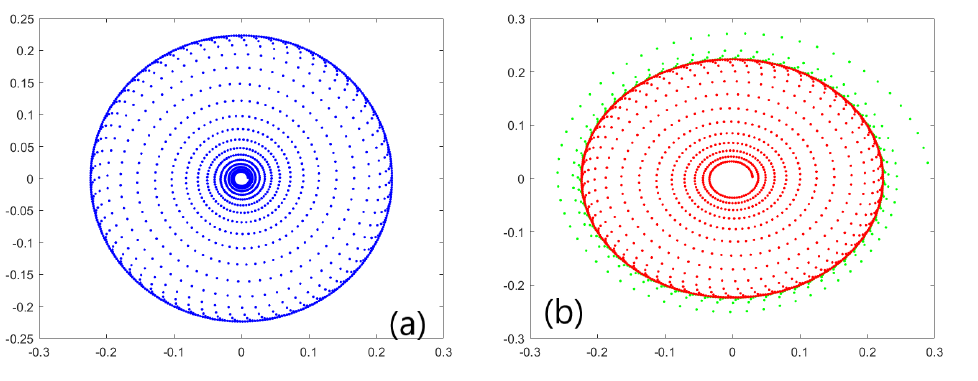
+ α 3 + α 2 − α 2 , β 2 ( α ) = − α 2 2 1 1 1